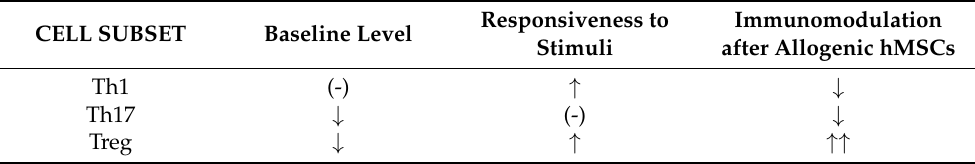
Responsiveness to Immunomodulation Stimuli after Allogenic hMSCs